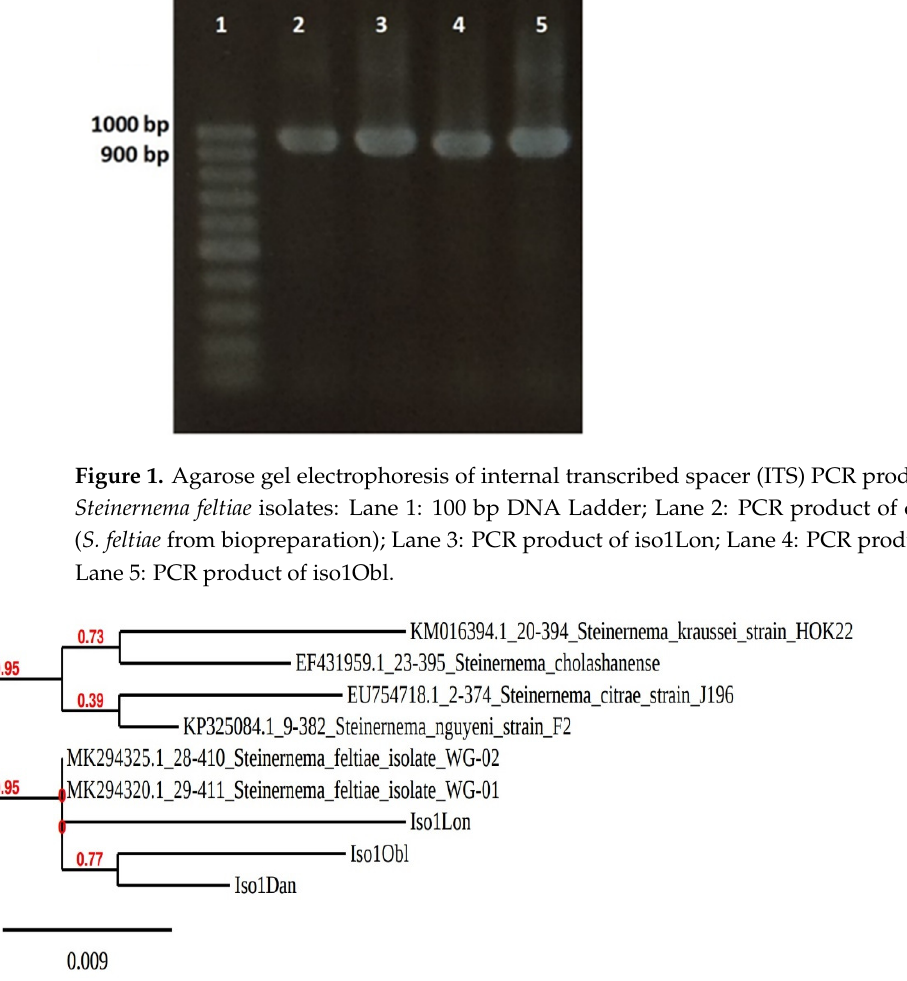
Figure 2. Phylogenetic relationships of three Poland EPN isolates based on analysis of internal transcribed spacers (ITS), using the Neighbor-Joining method.